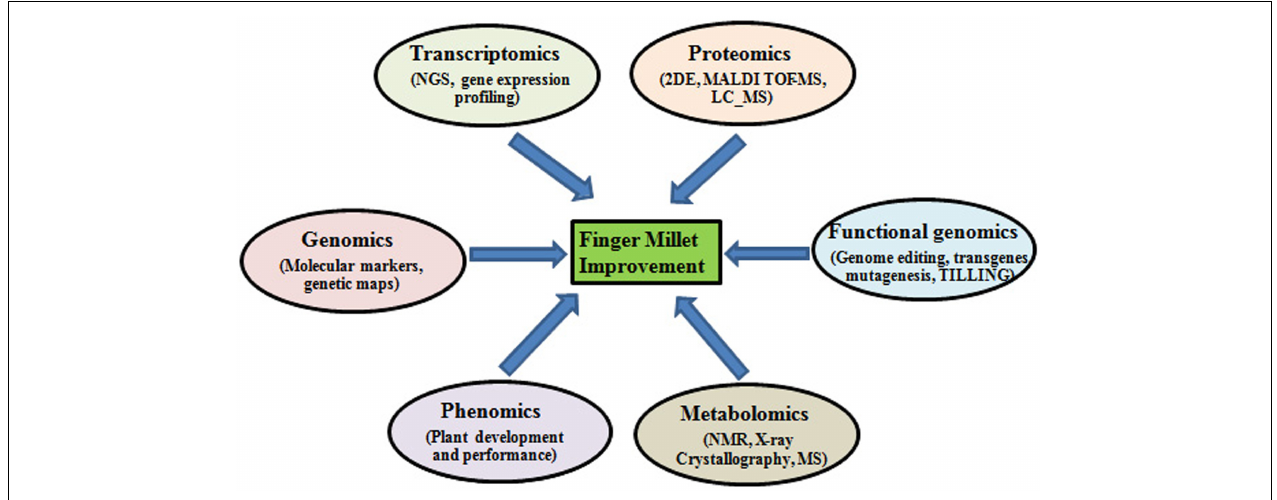
FIGURE 1 | Different omics approaches for improving abiotic and biotic stress tolerance in finger